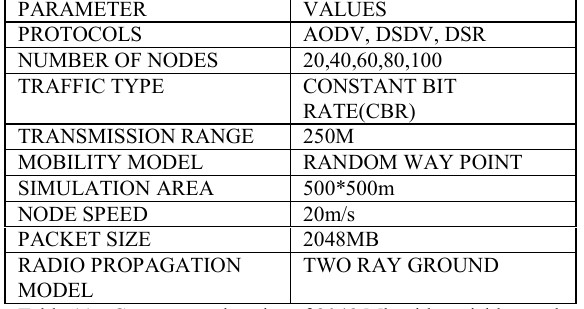
Table 11:- Constant packet size of 2048 Mb with variable number of